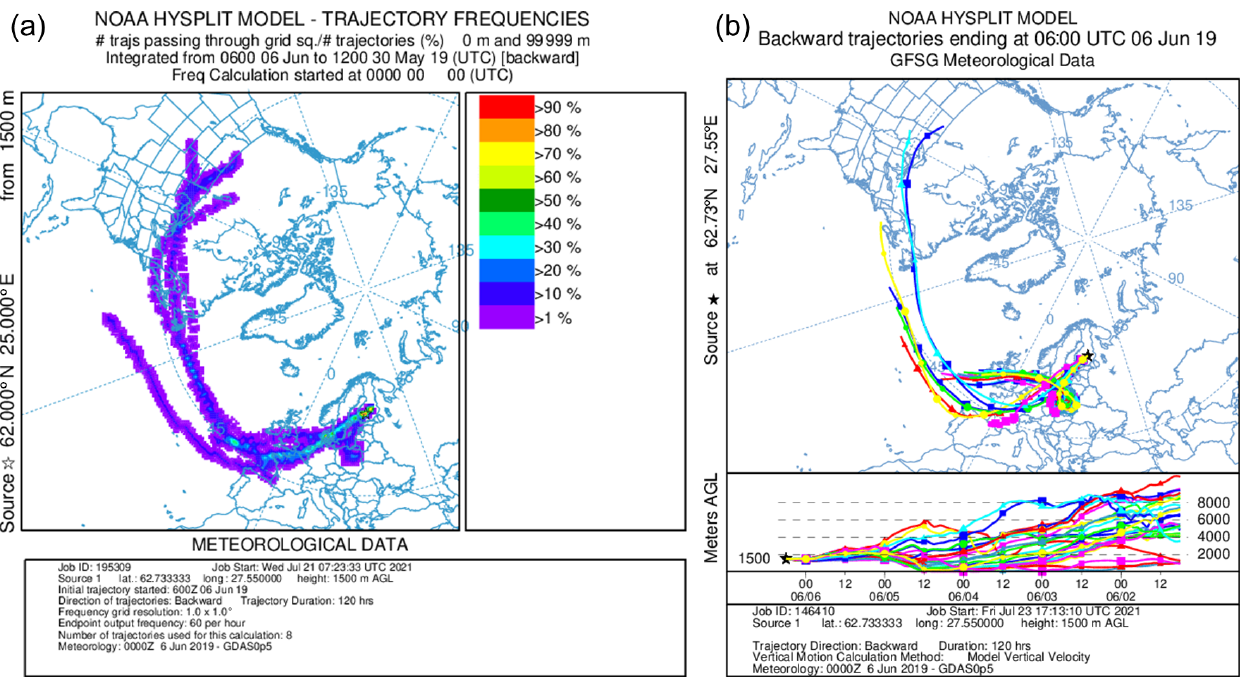
Figure 6. Five-day backward trajectories from the HYSPLIT model (a) in frequency option, and (b) in ensemble option, ending at 06:00UTC on 6 June 2019 for Kuopio, Finland. The end location of the air mass is at 1.5kma.g.l. in the range-transported plume.